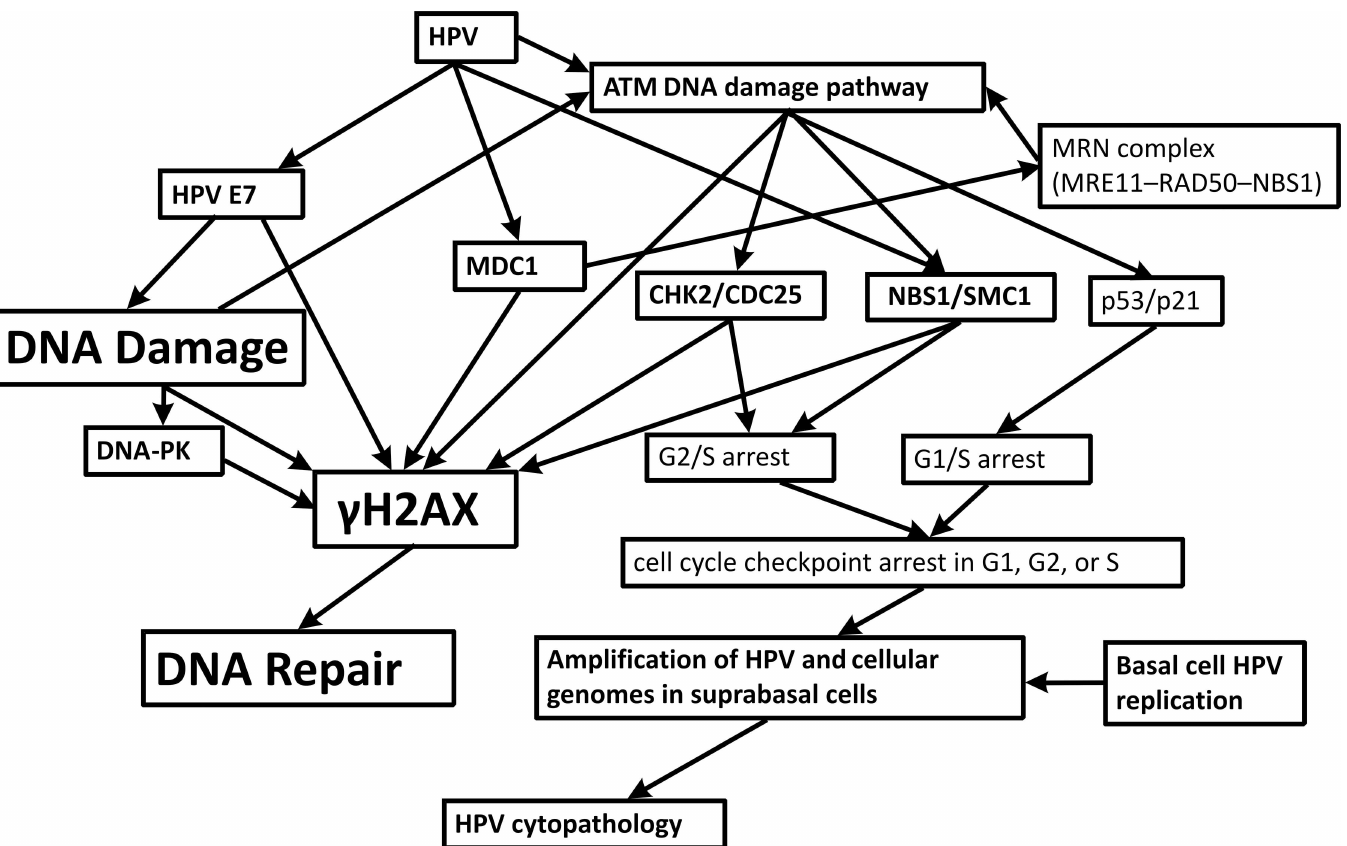
Fig 4. γ H2AXas a regulator of cellular responses to HPV infection. An ATM-dependent DNA damageresponse is inducedby HPV; howeverit is unclear which set of the ATM factors providenecessary functions. Complexfeedbackloops inducethe phosphorylation of H2AX, that is recruited to regions flanking sites of doublestrand breaks. Proteinsknown to directly bind to / interact with H2AX are marked in bold. γ H2AX forms complexeswith these proteins associatedwith the viral DNA in HPV positive cells. Many of these loops interact with the HPV genomeamplification that occurs duringcycle arrest in late S/